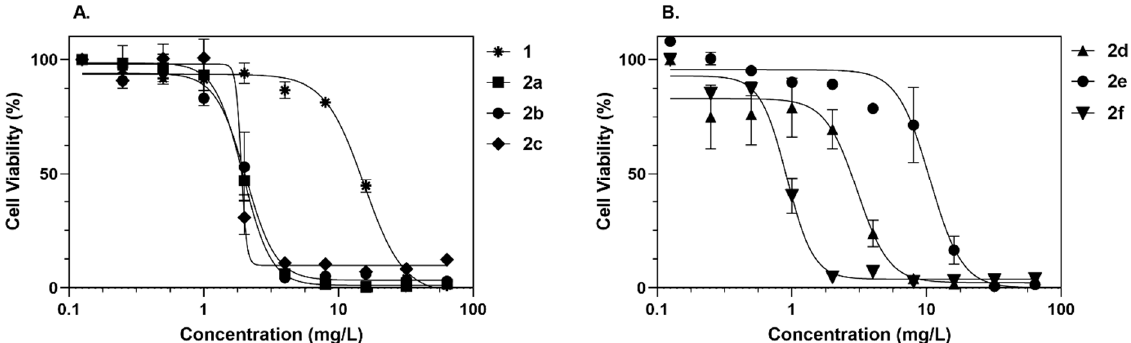
Figure 4. Cytotoxicity of the gold(III) complexes 1 , 2a , 2b , 2c ( A ) and 2e , 2d , 2f ( B ) on Jurkat E6.1 cells. Mean and SD of three experiments are represented in the graph.